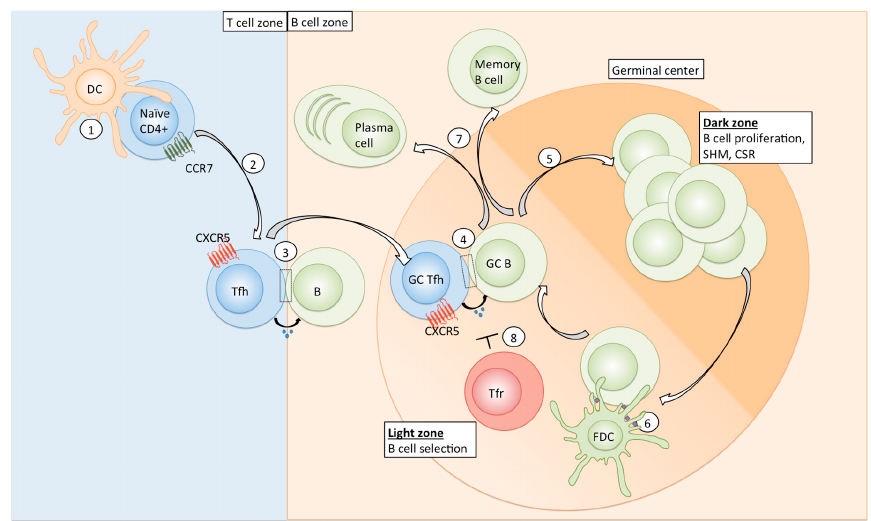
Figure 1. Overview of Tfh differentiation and function. Naïve CD4+ T cells are primed by antigen-presenting dendritic cells in the T cell zone of secondary lymphoid organs (1); Specific cytokines, co-signalling surface receptor molecules (see Table 1) and a prolonged DC-naïve CD4 interaction favour Tfh commitment. Tfh-polarized cells downregulate CCR7 and express CXCR5, the CXCL13 ligand, which allows their migration to the T-B-border (2); where first interaction with B cells occurs (3); Tfh cells then migrate into the germinal center, where further interaction with GC B cells sustains the GC Tfh polarization (4); In the dark zone of the GC, B cells undergo proliferation, affinity maturation via SHM, and CSR (5); B cells migrate to the light zone to receive survival and selection signals. They take up and process antigen (purple) from FDCs (6) and subsequently present it to GC Tfh cells (4). High affinity B cells are able to capture and present more antigen and therefore receive more Tfh cell help. Repeated circulation of B cells between DZ and LZ results in the acquisition of high levels of SHM and selection of high affinity clones. B cells eventually differentiate into antibody-producing plasma cells or memory B cells and enter the blood circulation (7); Tfr cells can inhibit GC Tfh and B cell responses via multiple mechanisms (8); DC: dendritic cell, Tfh: T follicular helper cell, SHM: somatic hypermutation, CSR: class switch recombination, FDC: follicular dendritic cell, DZ: dark zone; LZ: light zone; Tfr: follicular T regulatory cell. Table 1. Signalling molecules regulating Tfh differentiation in mice and humans. Molecule/Receptor Signalling